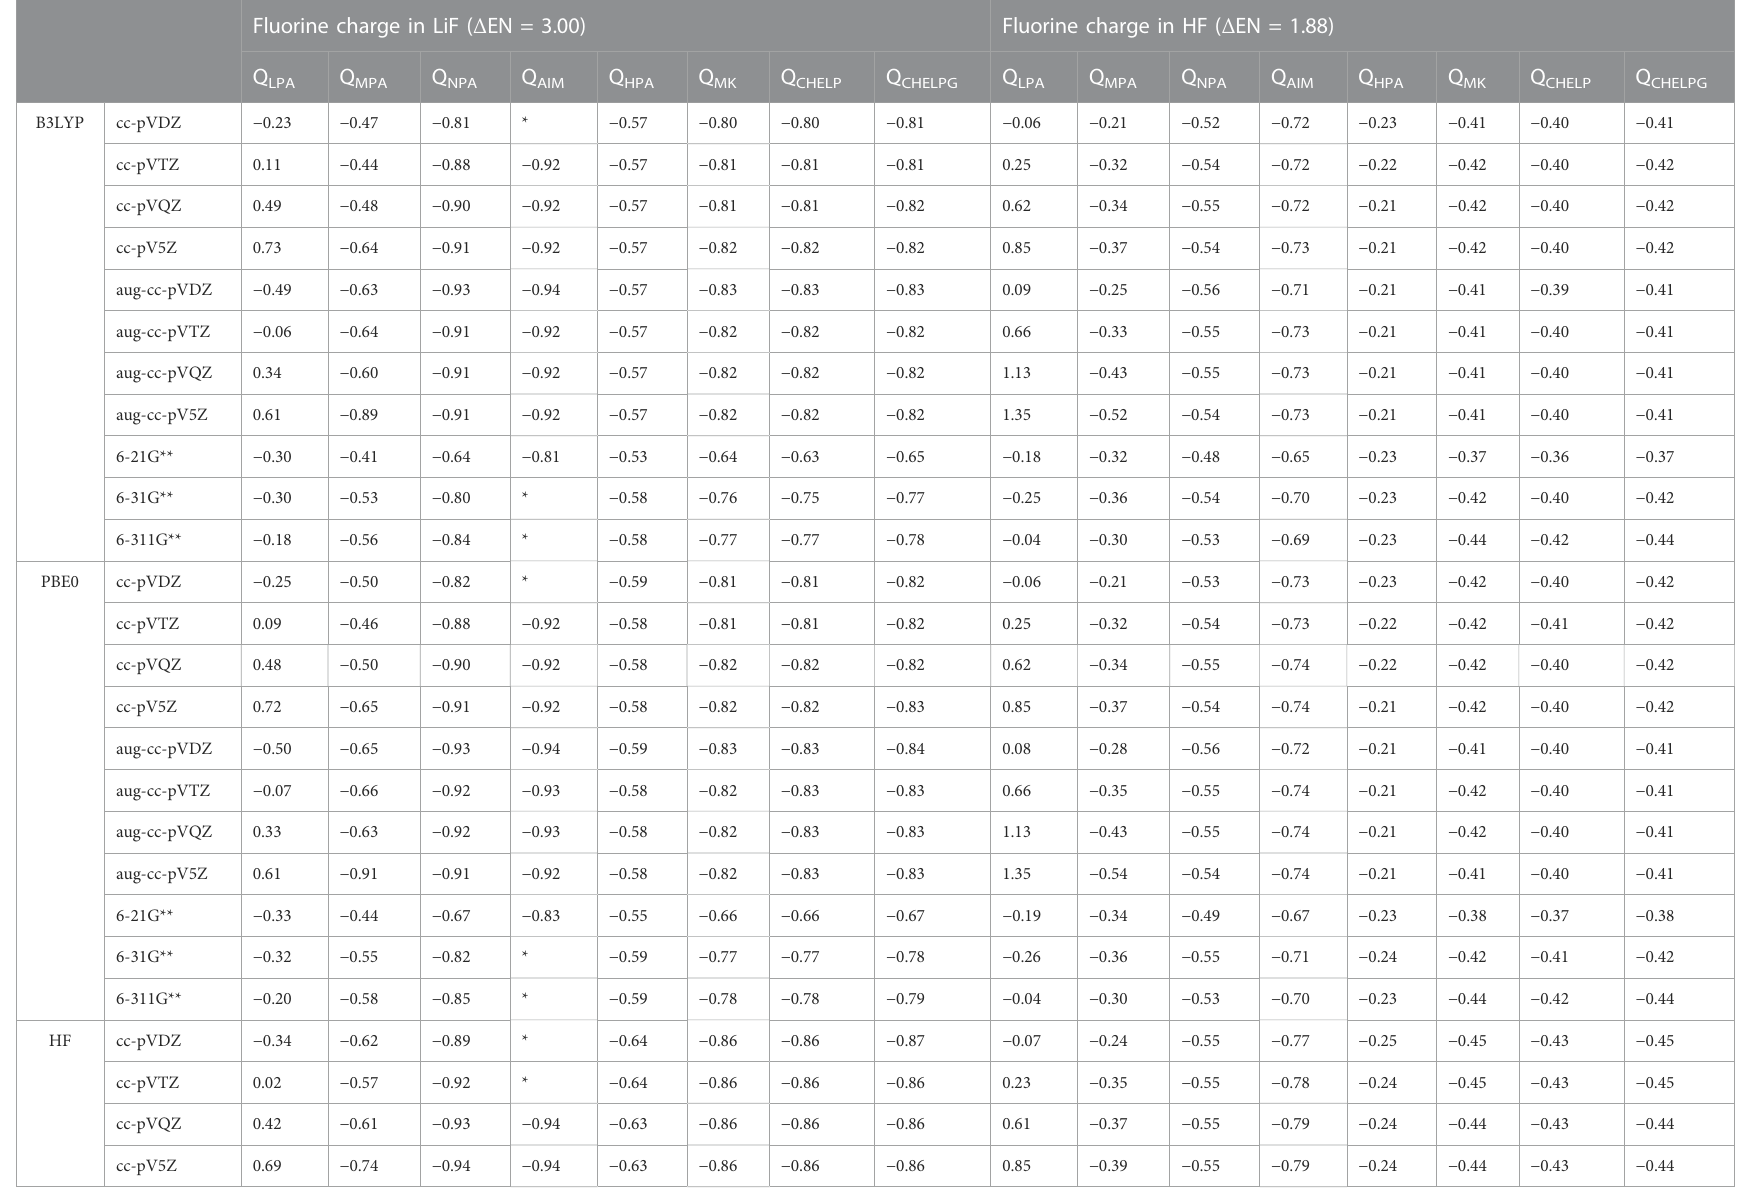
TABLE 1 Comparison of charges obtained for the most polar (LiF) and least polar (HF) diatomic molecules, using different quantum methods, population analysis schemes, and basis sets. Fluorine charge in LiF ( Δ EN = 3.00) Fluorine charge in HF ( Δ EN =